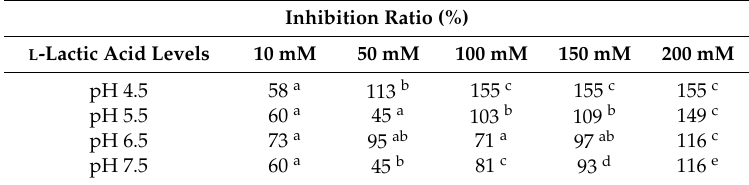
Table 2. The inhibitory effects of the MRS medium under difference pH values and L -lactic acid levels on the growth of HT-29 cell lines using MTT assay.